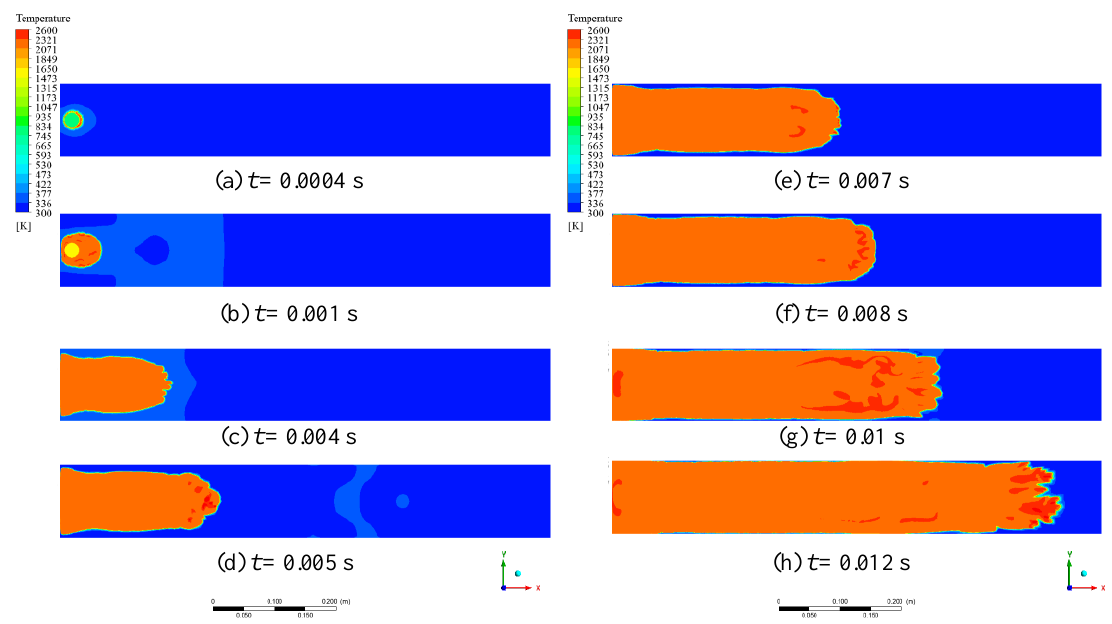
Figure 4. Flame propagation process of the stoichiometric mixture.